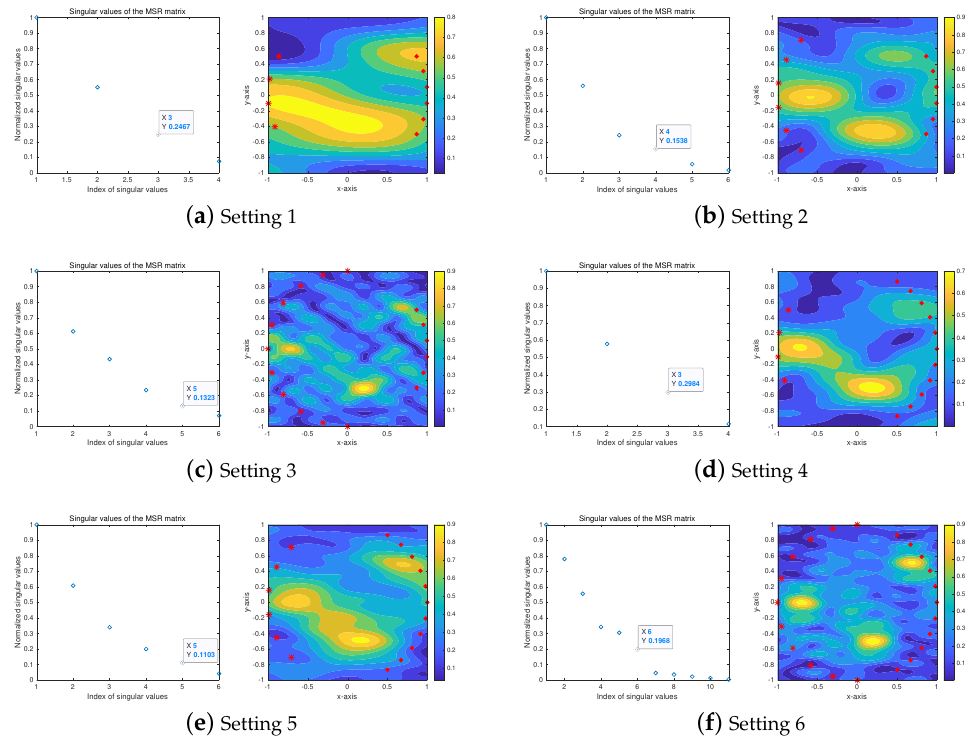
Figure 5. (Example 2) maps of F µ ( r ) . The red-colored marks ◦ and ∗ denote the incident and observation directions, respectively.